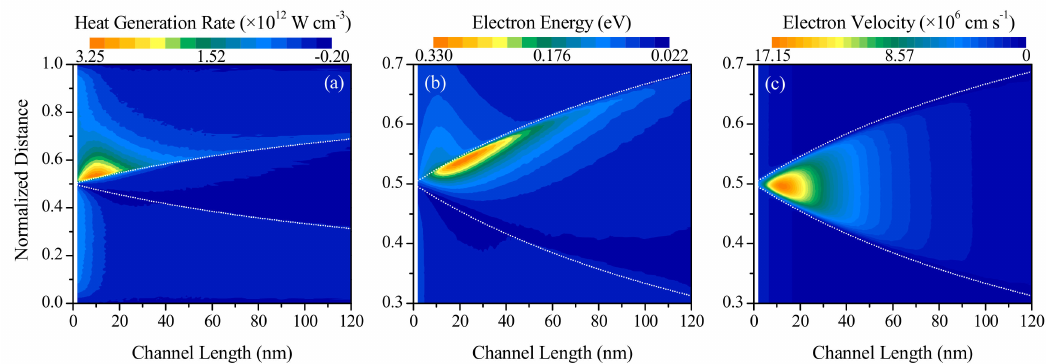
Figure 5. Variation of ( a ) heat generation rate, ( b ) electron energy, and ( c ) electron velocity as a function of the channel length of an n + nn + silicon device. The lower and upper white dotted lines correspond to the start and end of the channel, respectively.